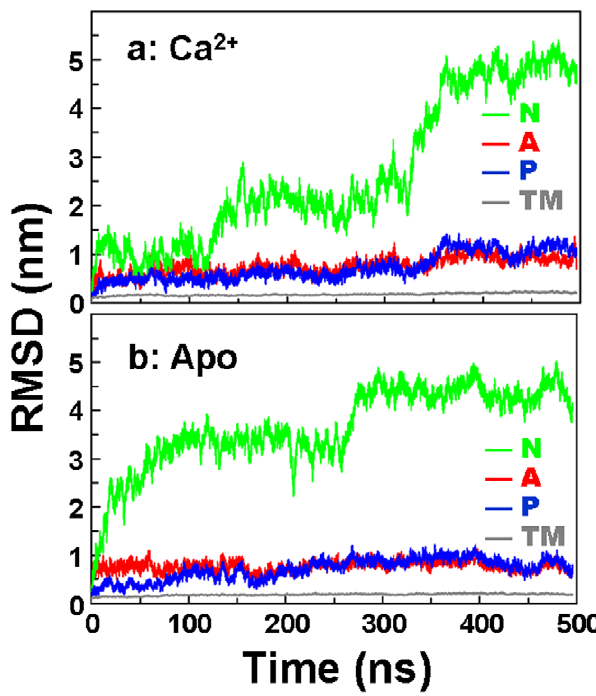
Figure 3. Backbone RMSD of each functional domain of SERCA. Domains are color-coded as indicated, as in Fig. 1. Backbone alignment used the TM domain as a reference.